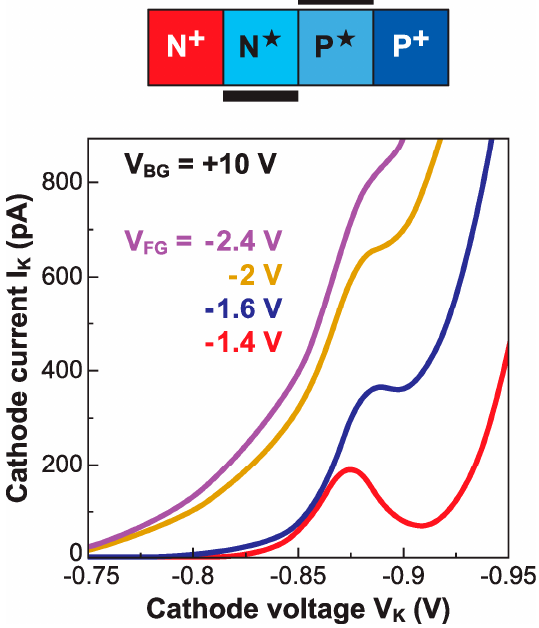
Figure 26. Experimental current–voltage characteristics of an electrostatic Esaki diode fabricated on undoped FD-SOI, showing the role of the gate voltage; with the same device parameters as in Figure 4 (adapted from [69]).